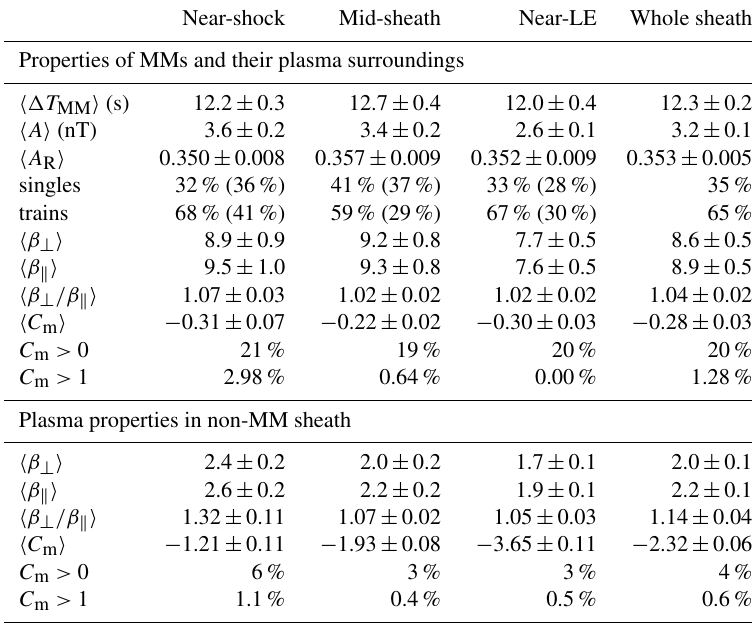
Table 3. Average properties of MMs and their division to the individual ones and the ones in trains in different sheath sub-regions (the percentages in parentheses indicate the division of singles and MMs in trains between different sub-regions). The typical plasma betas, plasma beta anisotropy and mirror instability threshold values and the relative amount of plasma in a certain sub-region that is above the mirror instability threshold ( C m = 0) and that exceeds C m = 1 in both plasma containing MMs and non-MM plasma are given. The last column shows the properties of MMs and plasma in the ICME-driven sheaths generally, i.e., in whole fractional distance interval from 0 to √ n , where δ is the standard deviation and n is the size of 1. The standard error of the mean (SE) defines the errors and is defined as SE = δ/ a sample.